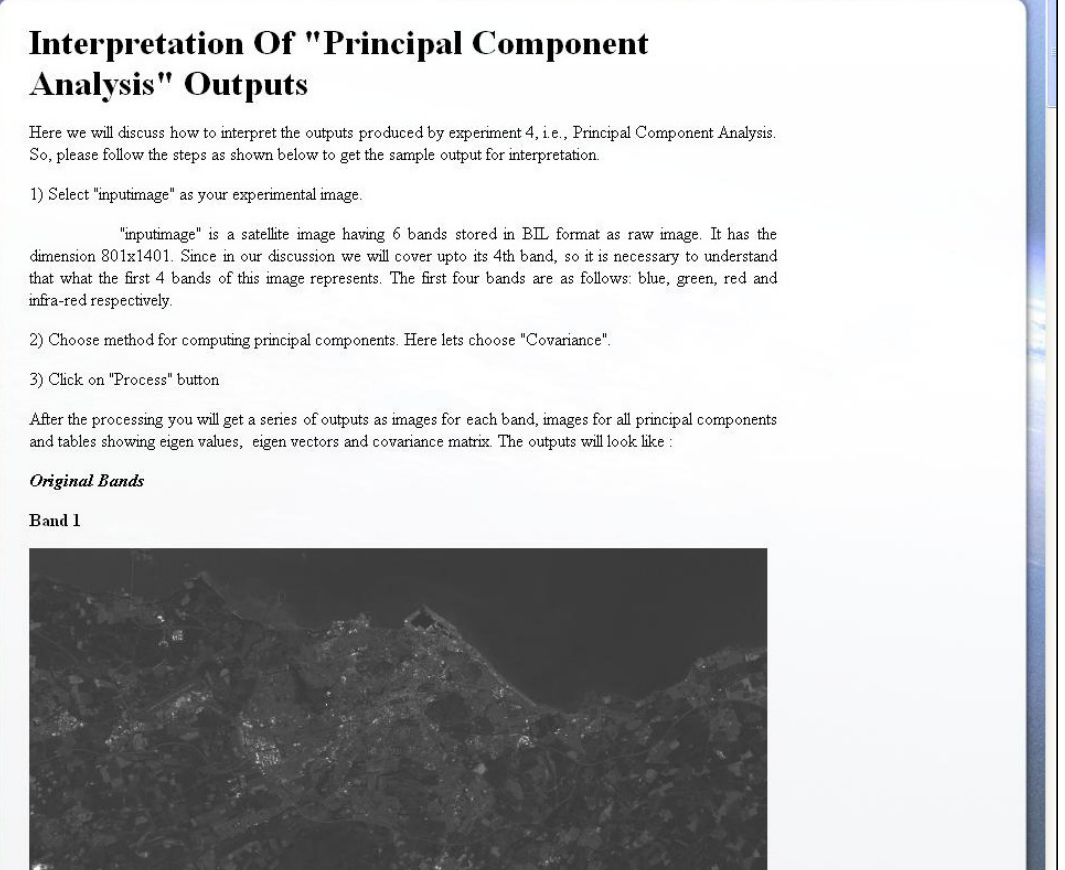
Figure 4. Interpretation